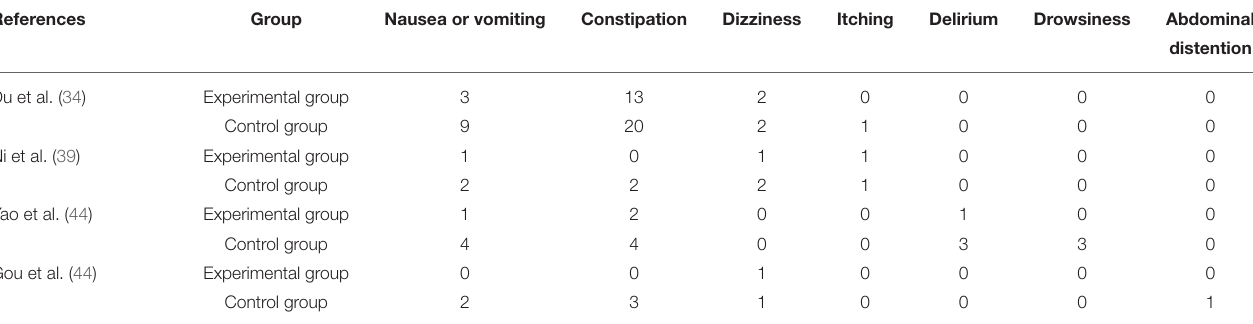
TABLE 5 | Details of adverse